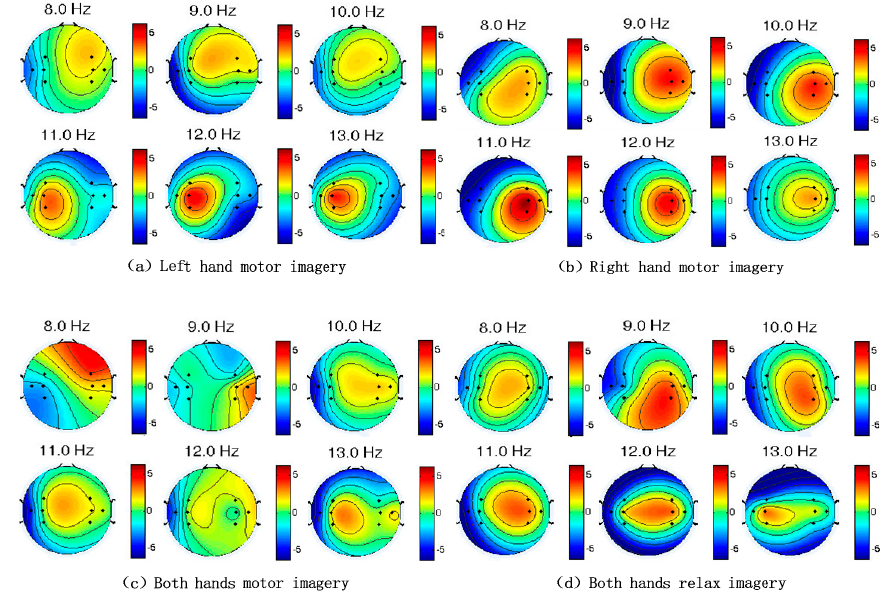
Figure 11. Topographies of power in 8–13 Hz frequency band during motor imagery of subject 1.